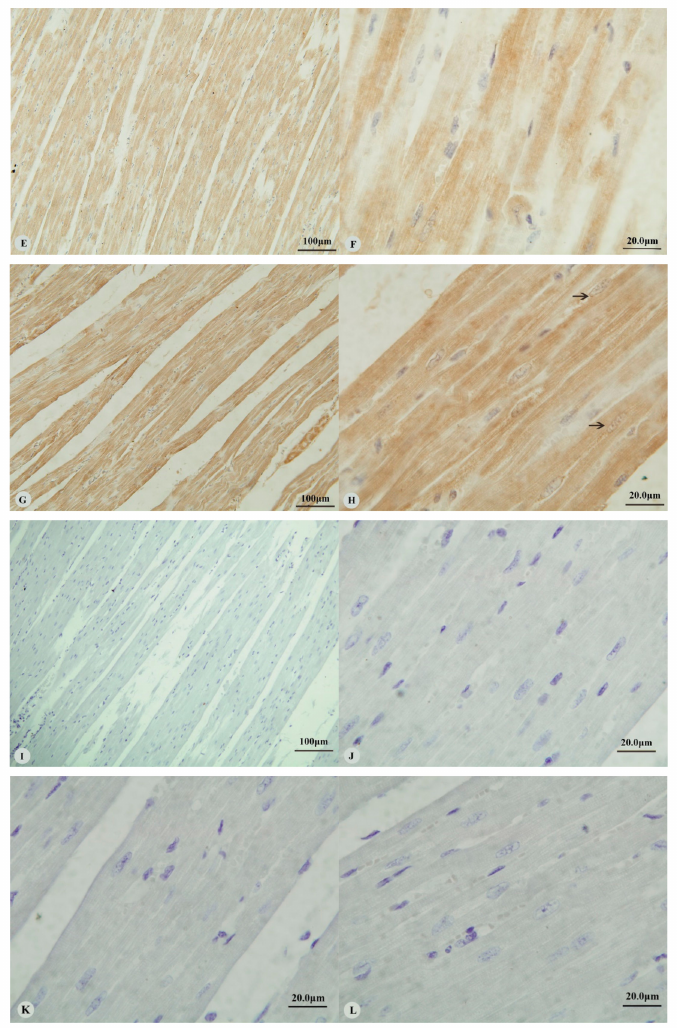
Figure 1. Immunostaining of four proteins in the heart of Tibetan sheep. All sections are from two-year-old sheep. ( A , B ): Hypoxia-inducible factor (HIF)-1 α immunostaining in the heart; ( C , D ): HIF-2 α immunostaining in the heart; ( E , F ): HIF-3 α immunostaining in the heart; ( G , H ): Vascular endothelial growth factor (VEGF) immunostaining in the heart; ( I – L ): control of HIF-1 α , HIF-2 α , HIF-3 α and VEGF in heart respectively. Arrows in ( B , D , H ): HIF-1 α , HIF-2 α and VEGF immunostaining in myocardial nuclei, respectively. The positive immunostaining showed brown with non-immunostained nuclei blue. ( A , C , E , G , I ): 20 × ; ( B , D , F , H , J – L ): 100 ×